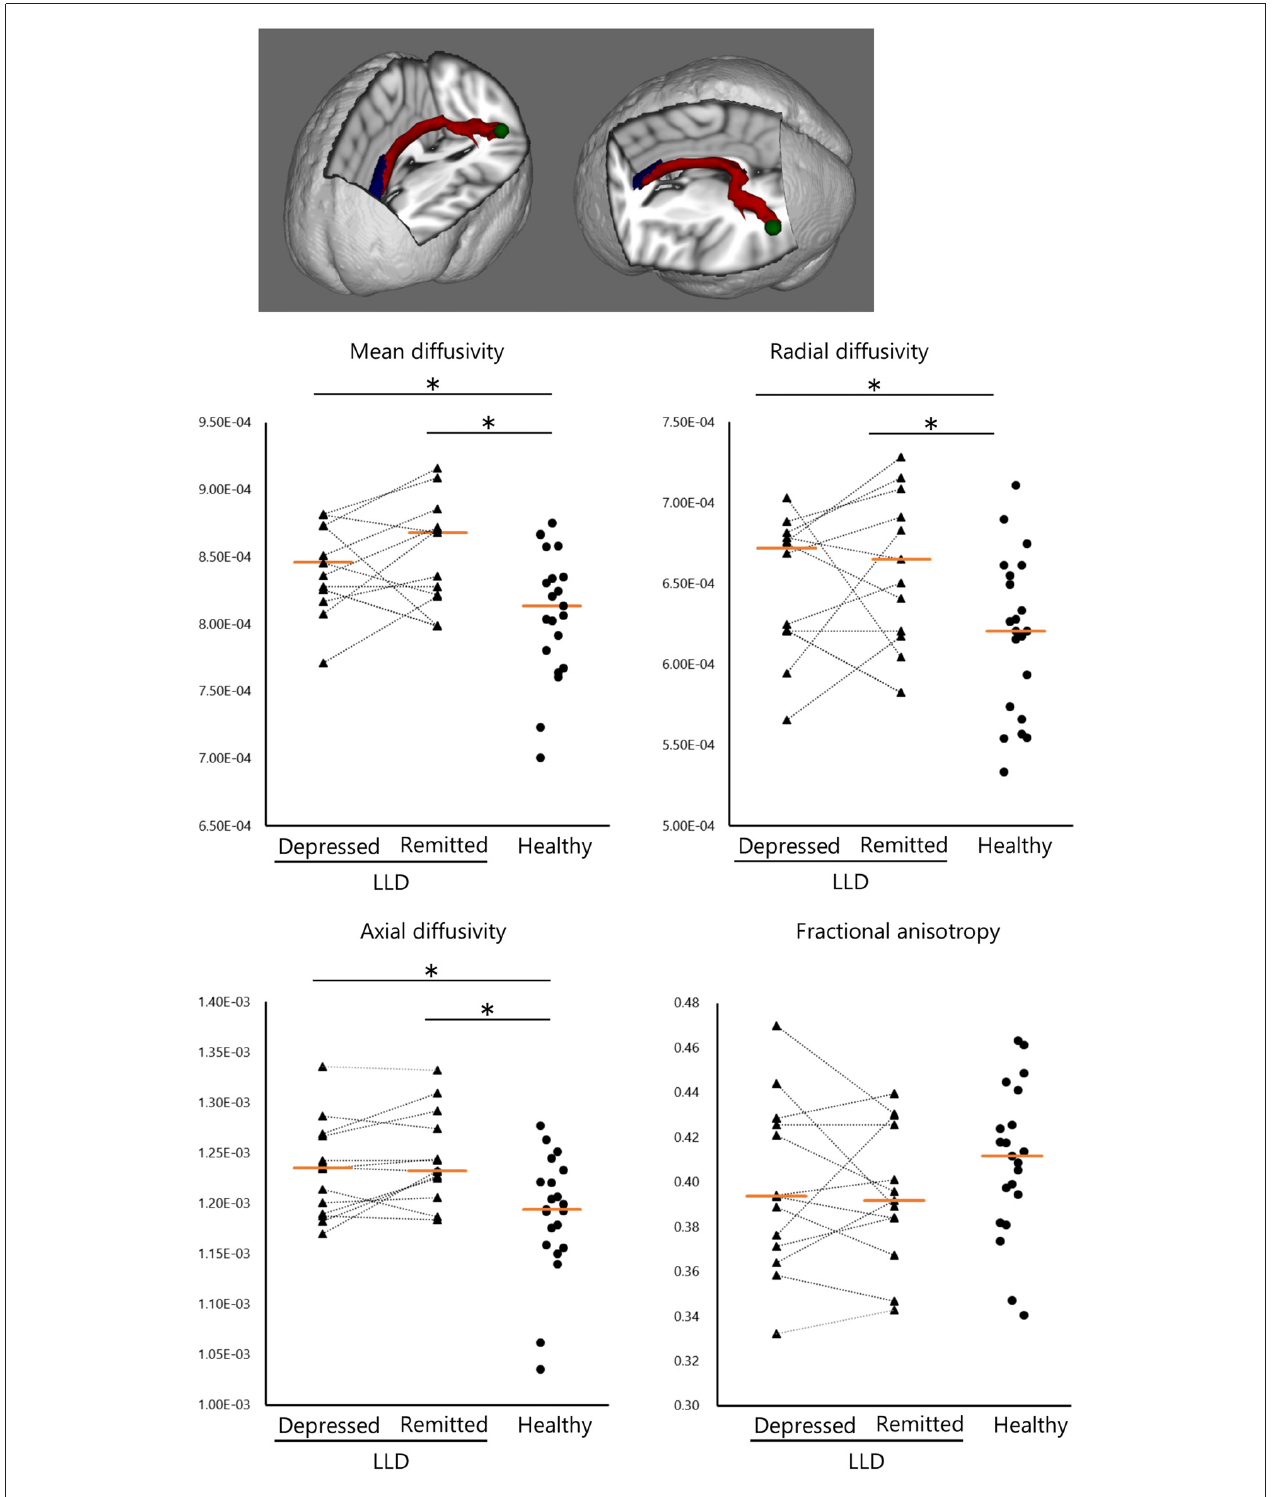
FIGURE 2 | Structural white matter (WM) connectivity between the left anterior cingulate and posterior superior temporal gyrus (ACC–pSTG). Patients with LLD ( n = 13) in the depressed and remitted phases demonstrated significantly higher WM connectivity in the ACC–pSTG region than did healthy subjects ( n = 21), in terms of mean, radial and axial diffusivity, but not in fractional anisotropy. Tangerine bars represent the median value of Z-score for each diffusivity. Y-axis represents z-score. ∗ p < 0.05 by Mann-Whitney U test or Wilcoxon signed ranks test.